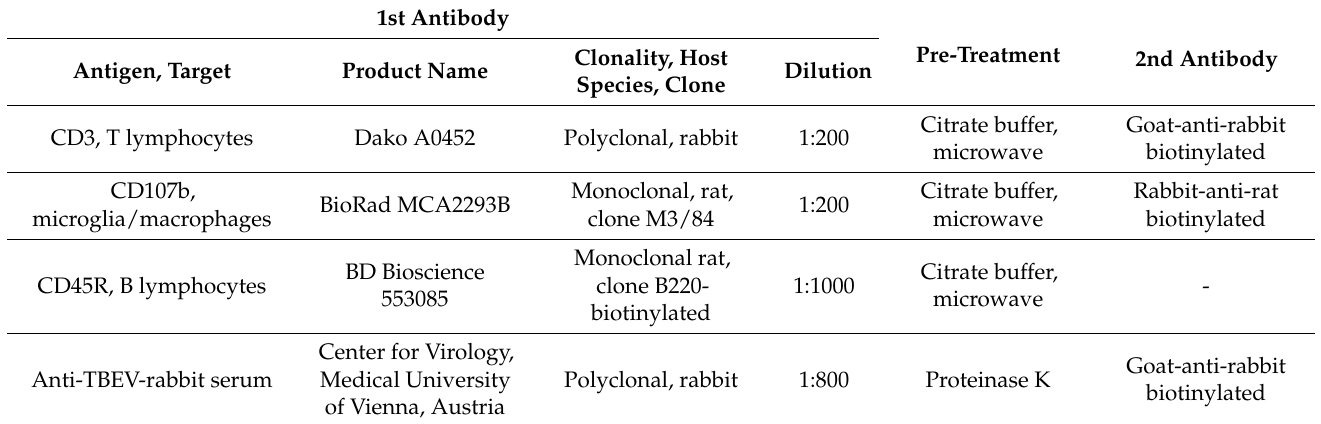
Table 1. Antibodies and related reagents used for immunohistochemical